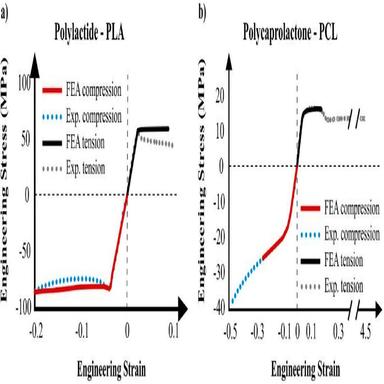
Experimental tensile and compression stress–strain response curve-fitted with FEA results for: a) PLA and b) PCL material.